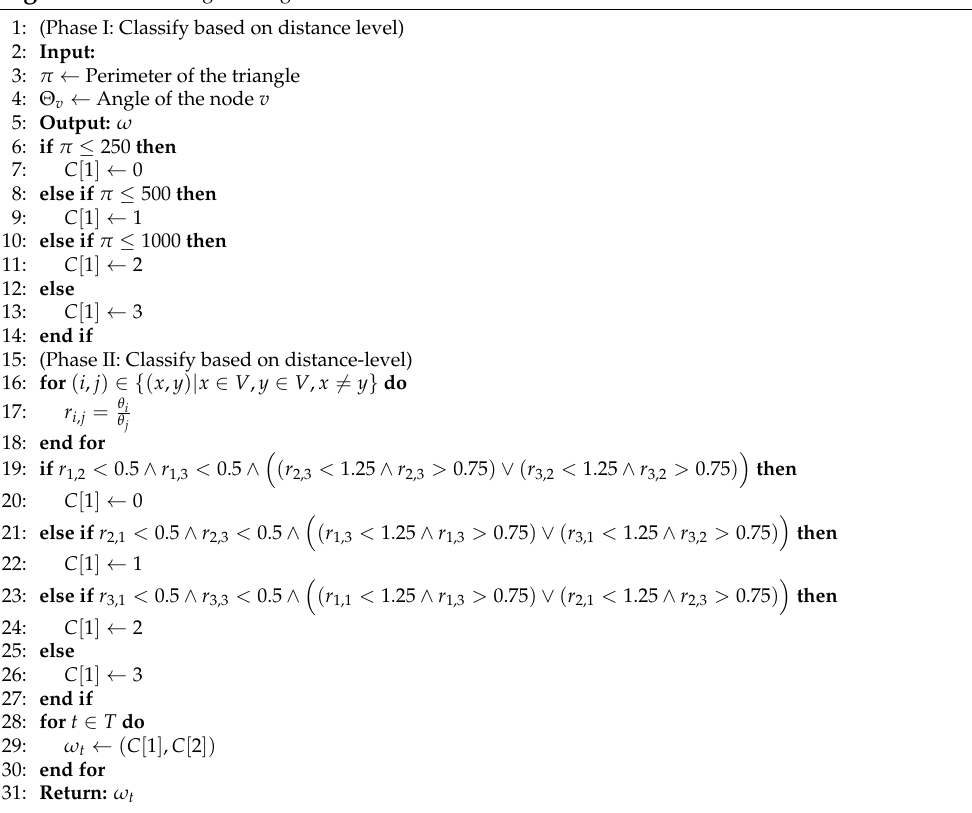
Algorithm 1 Two-digit coding